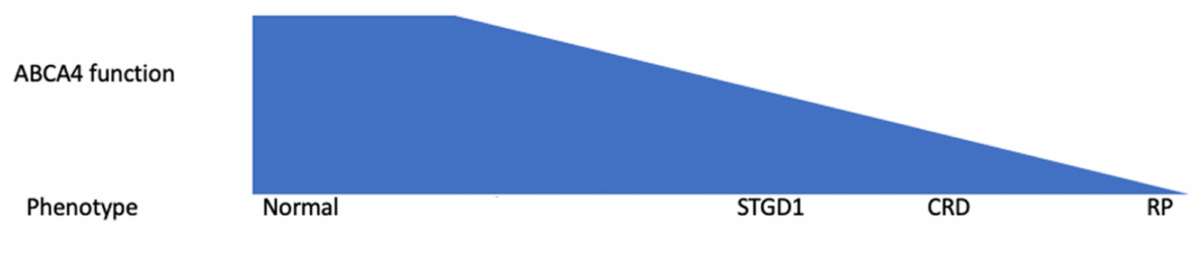
Figure 5. Schematic diagram illustrating the correlation between the amount of functional ABCA4 protein and the phenotype based on early studies that predicted that a lower amount of functioning ABCA4 protein was associated with more severe phenotypes. Figure adapted from Maugeri et al.